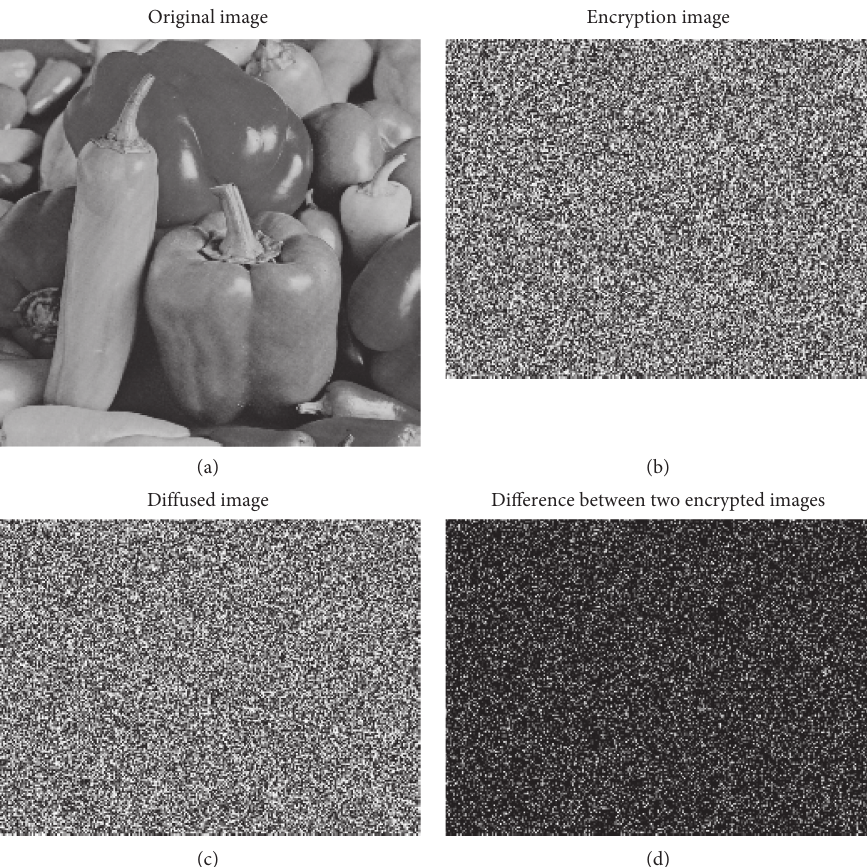
Figure 5: Results of gray image parallel compression perception encryption: (a) original image, (b) compressed sensing encrypted image, (c) diffused cipher text image, and (d) difference between (b) and